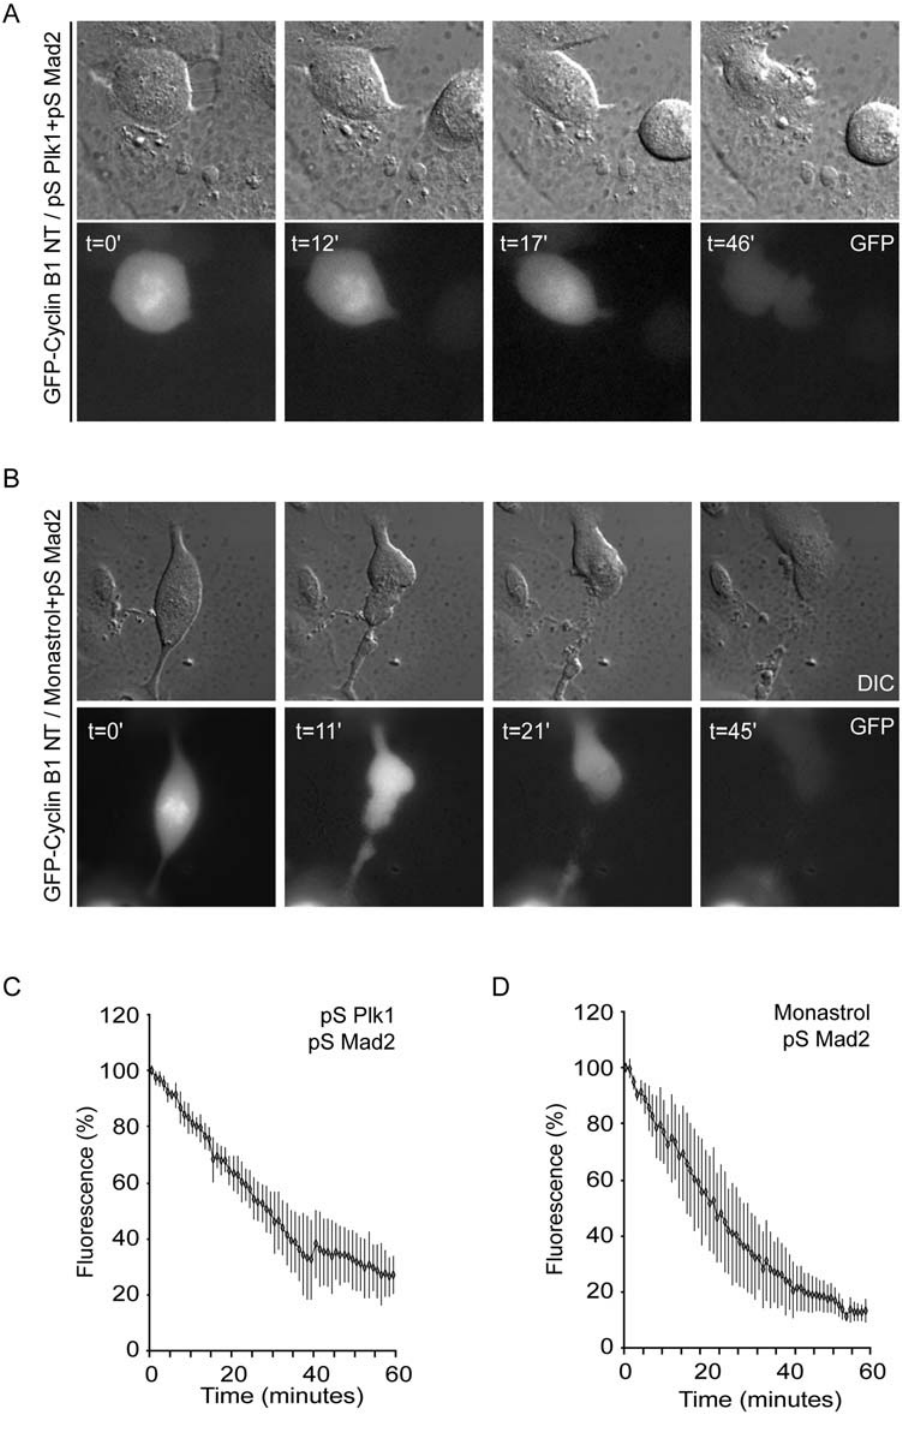
Figure 1. APC/C-Cdc20 Activity in Plk1-depleted U2OS cells. A–B U2OS cells were transiently transfected with 1 m g of GFP-Cyclin B1-NT, 10 m g of pS-Plk1 and 10 m g of pS-Mad2 as indicated. 18 h after transfection, cells were incubated for 24 h in thymidine. 10 h after washing away thymidine, cells were transferred to the heated stage of a time-lapse microscope. At indicated time points, DIC images and fluorescent light were analyzed. Directly after washing away thymidine, monastrol was added to culture medium, where indicated. C, D Fluorescence levels were quantified using Metamorph software (n=5 for each condition). Quantified images were plotted from the time of mitotic entry as define by nuclear envelope breakdown (t=0) and the standard error of the mean of 5 experiments is indicated.